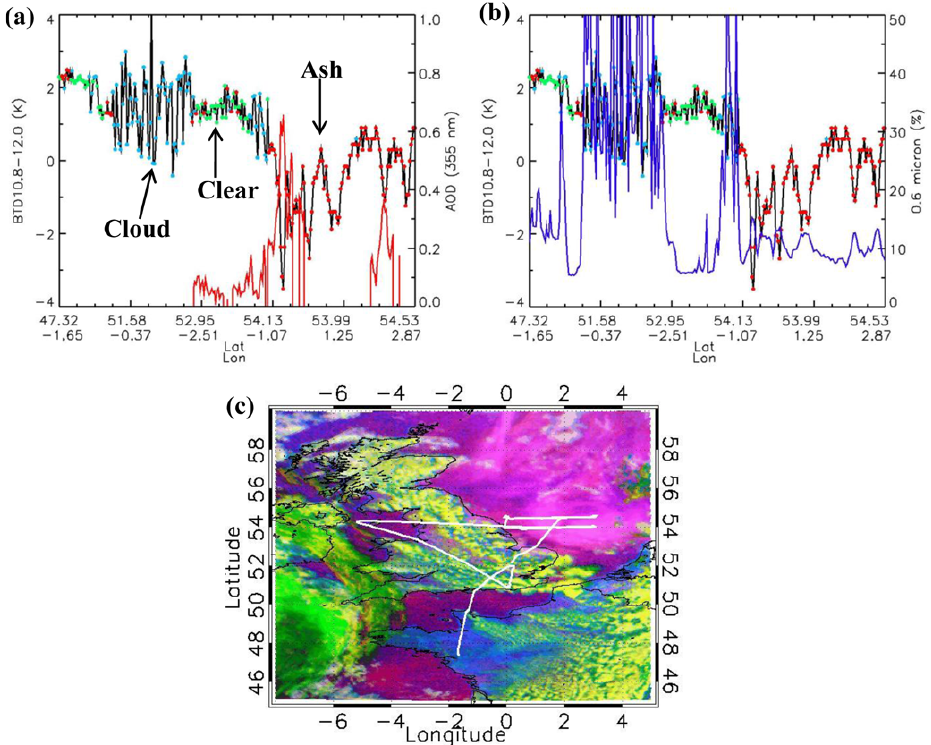
Fig. 7. Panels (a) and (b) are the same as panels (a) and (b) in Fig. 6 except the aircraft AOD and SEVIRI measurements from 17 May are shown here. (c) The 17 May BAe146 aircraft flight is overlaid in white on the SEVIRI RGB image from 14:00UTC; for this flight, the aircraft took off in northwestern France at 11:26UTC and landed in southeastern England at